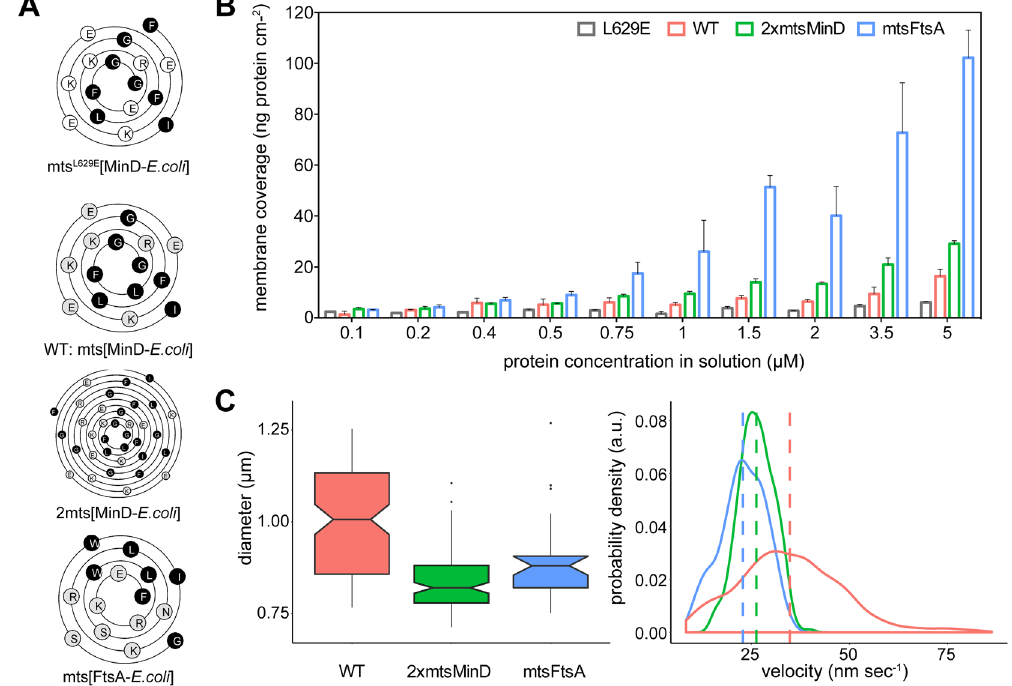
Figure 3. Increased membrane binding correlates with decreased treadmilling of FtsZ filaments. ( A ) Wenxiang diagrams 38 representing the amphipathic membrane targeting sequences examined in this study. The plots depict the conical projection of each alpha-helix onto a plane, with the C-terminus of the helix in the centre and the N-terminus at the edge. Hydrophobic sides are highlighted black and hydrophilic sides in grey. ( B ) Membrane coverage in ng protein/cm 2 of four FtsZ-YFP-mts constructs: mts [MinD- E. coli ] (red); 2xmts [MinD- E. coli ] (green); mts [FtsA- E. coli ] (blue) and mts * [L629E] (grey), determined via quartz crystal microbalance analysis. Error lines represent SEM of three independent experiments. Figure generated using Graphpad Prism 8.3.1 39 . ( C ) Diameter and velocity distributions of FtsZ chimera vortices. The notched boxplot in the upper panel displays the median diameter of the rings obtained for each protein variant. Notches display a 95% confidence interval. The lower panel displays the velocity shift for 2xmts [MinD- E. coli ] (26 ± 4 nm s − 1 , n = 305) and mts [FtsA- E. coli ] (23 ± 6 nm s − 1 , n = 228) compared to the mts [MinD- E. coli ] displaying a mean rotational speed of 35 ± 13 nm s − 1 (n = 1359) ( p < 0.05 , t-test two-sided hypothesis). Representative kymographs can be seen in S4 Fig, lower row. Figures were generated using R Core Team, 2019 34 , ggplot2 35